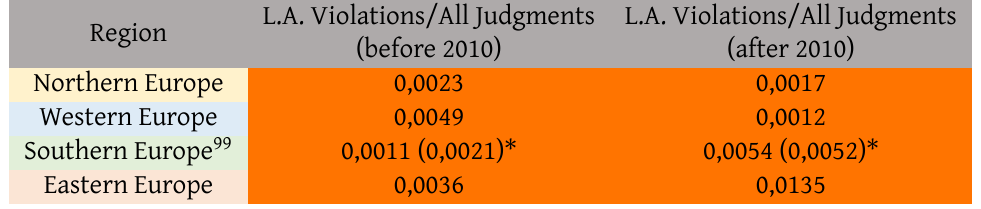
Table II: Ratio of L.A. violations/All judgments before and after 2010, by